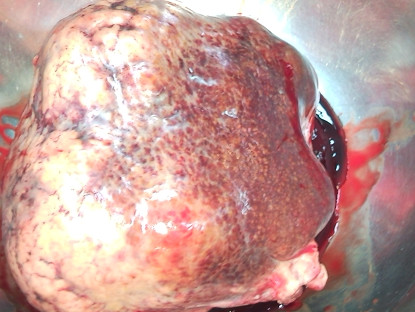
Resected tumor mass.